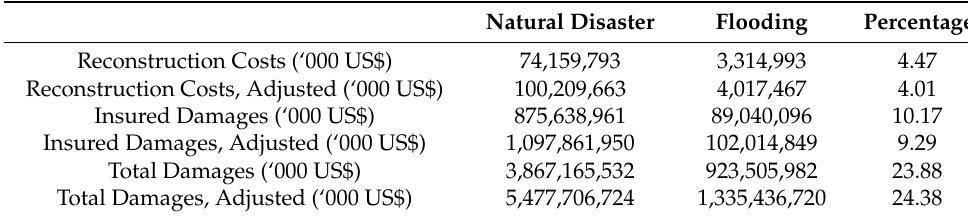
Table 2. Economic cost of flooding as against natural